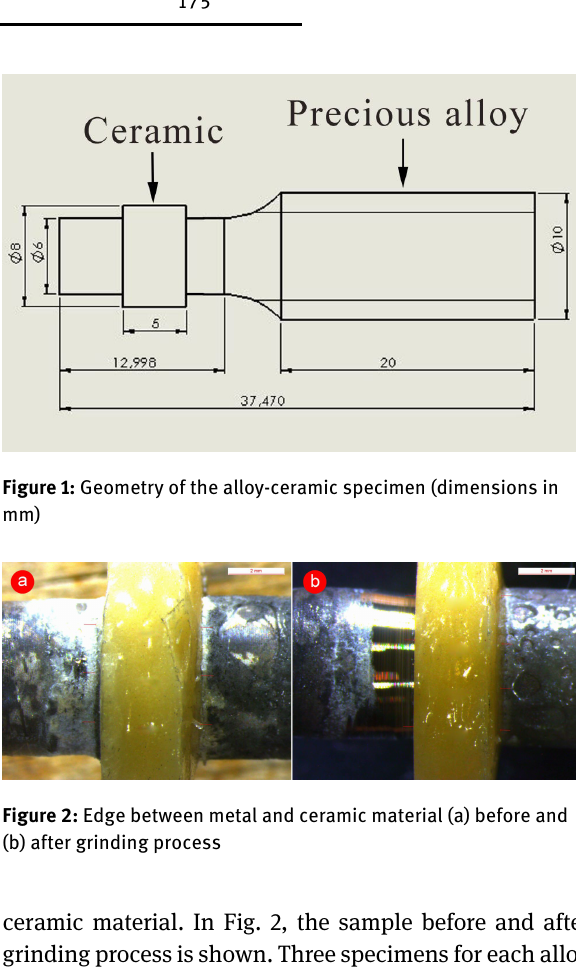
ceramic material. In Fig. 2, the sample before and after grinding process is shown. Three specimens for each alloy form (PF and DF) were manufactured and mechanically